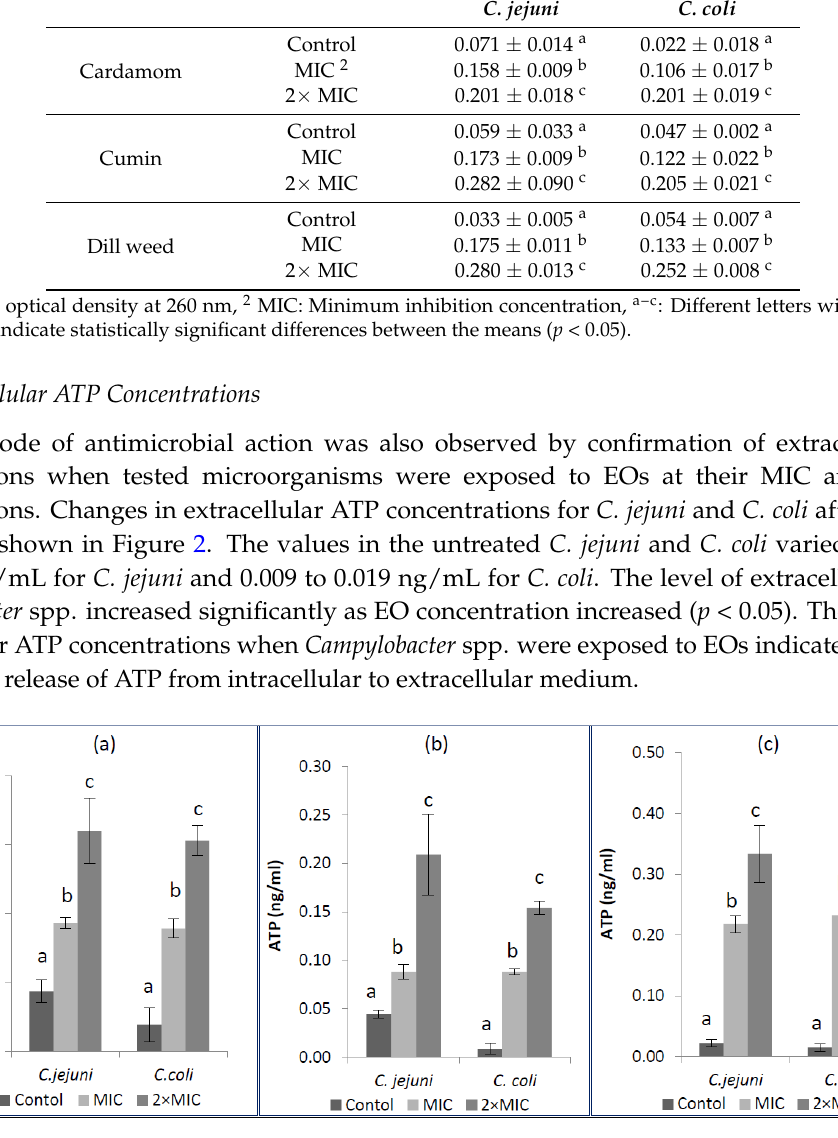
Table 3. Cell constituent release of Campylobacter spp. after adding essential oils.